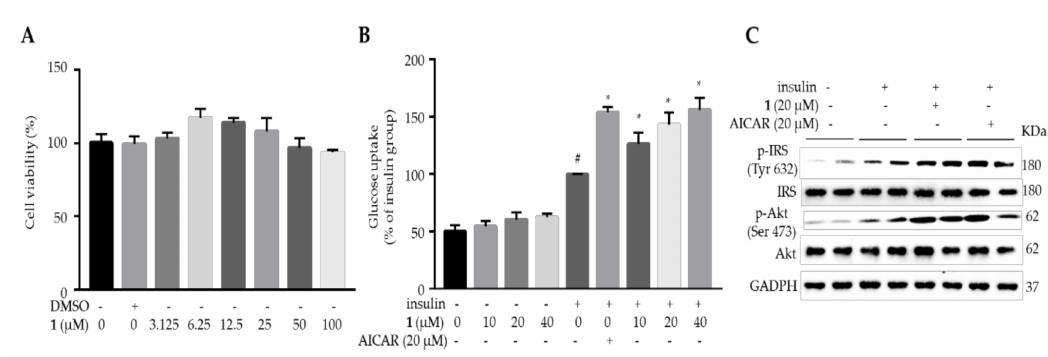
Figure 3. Compound 1 enhanced insulin-stimulated glucose uptake on C2C12 myotubes through activating insulin signaling pathway. ( A ) Cytotoxicity of compound 1 on C2C12 myotubes when treated for 24 h by MTT assay. ( B ) Compound 1 increased insulin-stimulated glucose uptake on C2C12 myotubes. AICAR was used as a positive control. ( C ) Compound 1 activated the insulin signaling pathway in C2C12 myotubes. The expressions of p -IRS-1, IRS-1, p -Akt, Akt, and GAPDH were analyzed by Western blots. “ + ” means presence, and “ − ” means absence. Data are expressed as mean ± SD, n = 6. # p < 0.0001, control vs. insulin; * p < 0.001, compound 1 or AICAR vs.